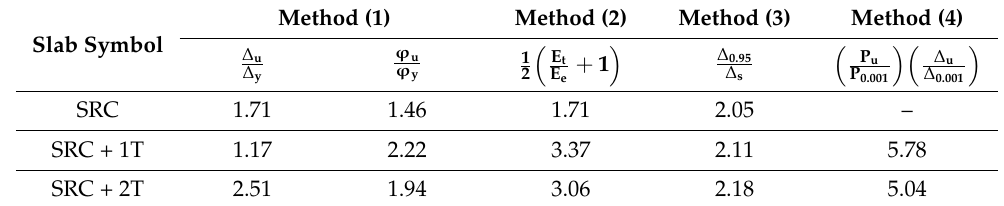
Table 8. Comparison of ductility values for the three tested slabs computed using different methods.